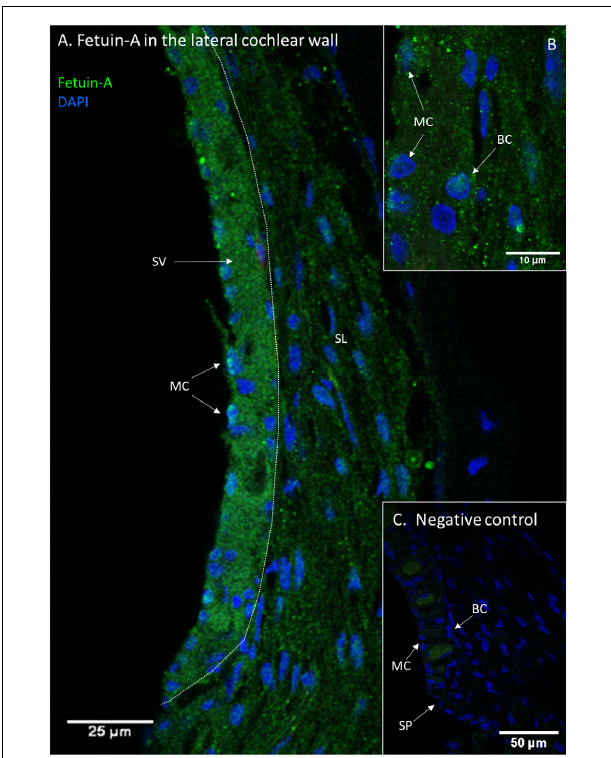
FIGURE 3 | Fetuin-A in the lateral cochlear wall. Protein localization of Fetuin-A in the lateral cochlear wall of a control guinea pig. Spiral ligament (SL); Stria vascularis (SV); Spiral prominence (SP); Marginal cell (MC); Basal cell (BC). (A) Fetuin-A protein in the spiral ligament, spiral prominence, and stria vascularis. (B) Inset of higher magnification of stria vascularis. Marginal cells (MC) and also basal cells (BC) have Fetuin-A protein. (C) Negative control of lateral wall with stria vascularis, spiral prominence and spiral ligament. Vessels have a weak unspecific staining.